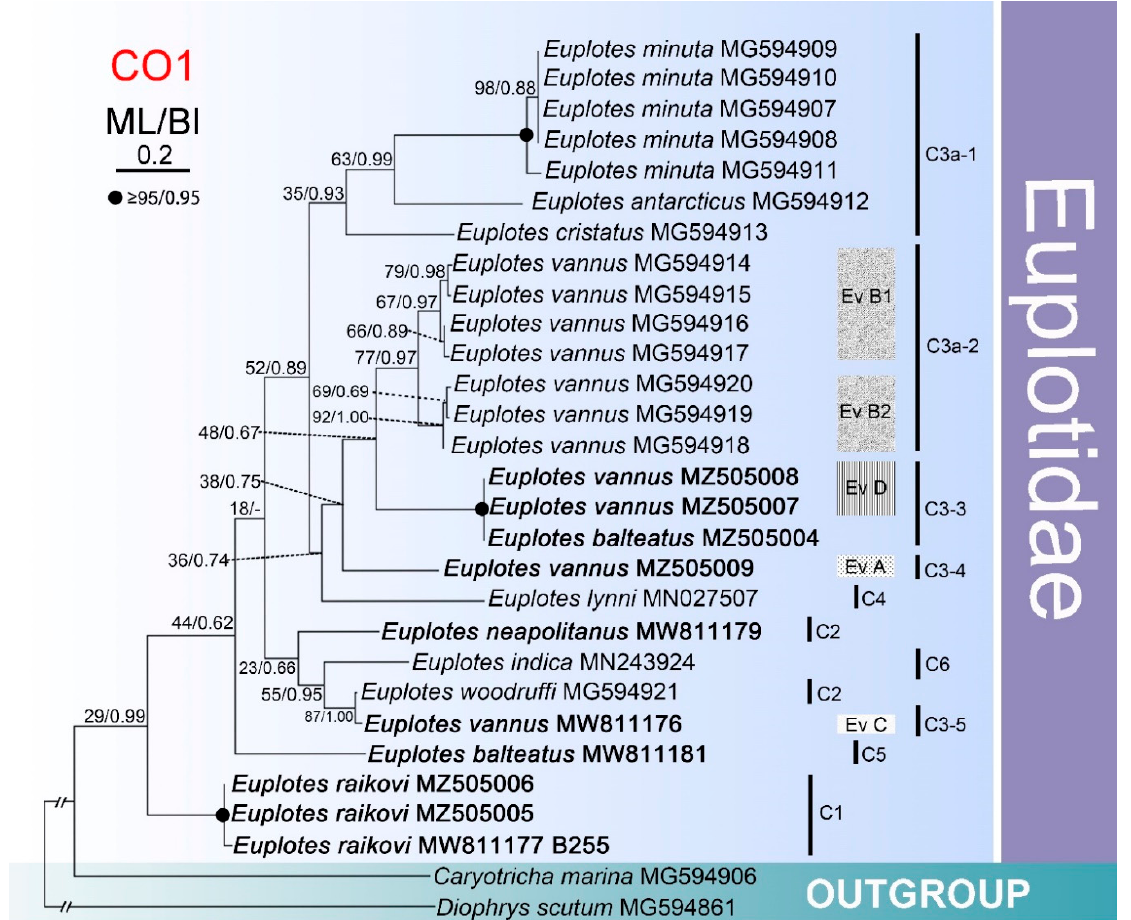
Figure 4. Maximum likelihood (ML) tree inferred from mitochondrial cytochrome c oxidase subunit 1 (CO1) nucleotide sequences of ten Euplotes species showing nodal support for ML and BI analyses. Newly-sequenced species are shown in bold. Disagreements between ML and BI are shown by hyphens. C1–6 represent different clades and Ev A–D for groups of Euplotes vannus . The scale bar corresponds to 20 substitutions per 100 nucleotide positions.